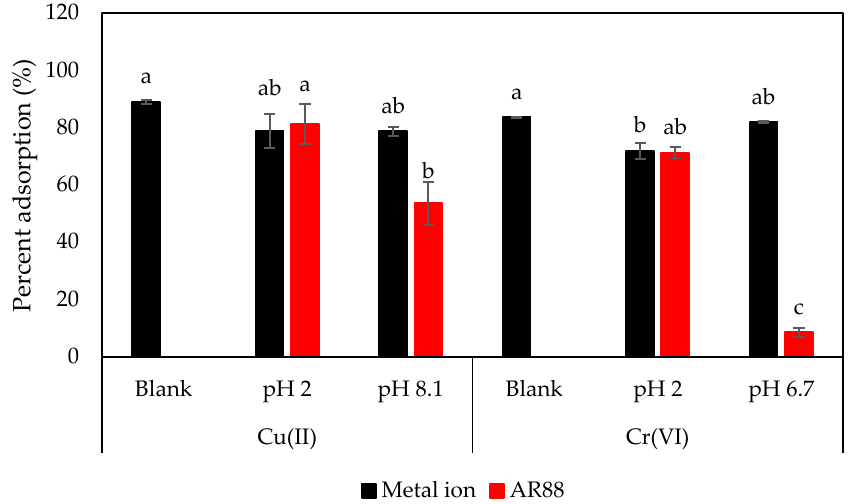
Figure 9. Effect of AR88 on Cu(II) and Cr(VI) adsorption. [Blank: no presence of AR88 dye, pH 8.1 for Cu(II) and pH 6.7 for Cr(VI), C-ZLCH: 0.01 g, volume: 50 mL, metal ions concentration: 25 mg/L, pH: 8.1 for Cu(II) at 60 min, pH: 6.7 for Cr(VI) at 90 min, temperature: 30 °C].